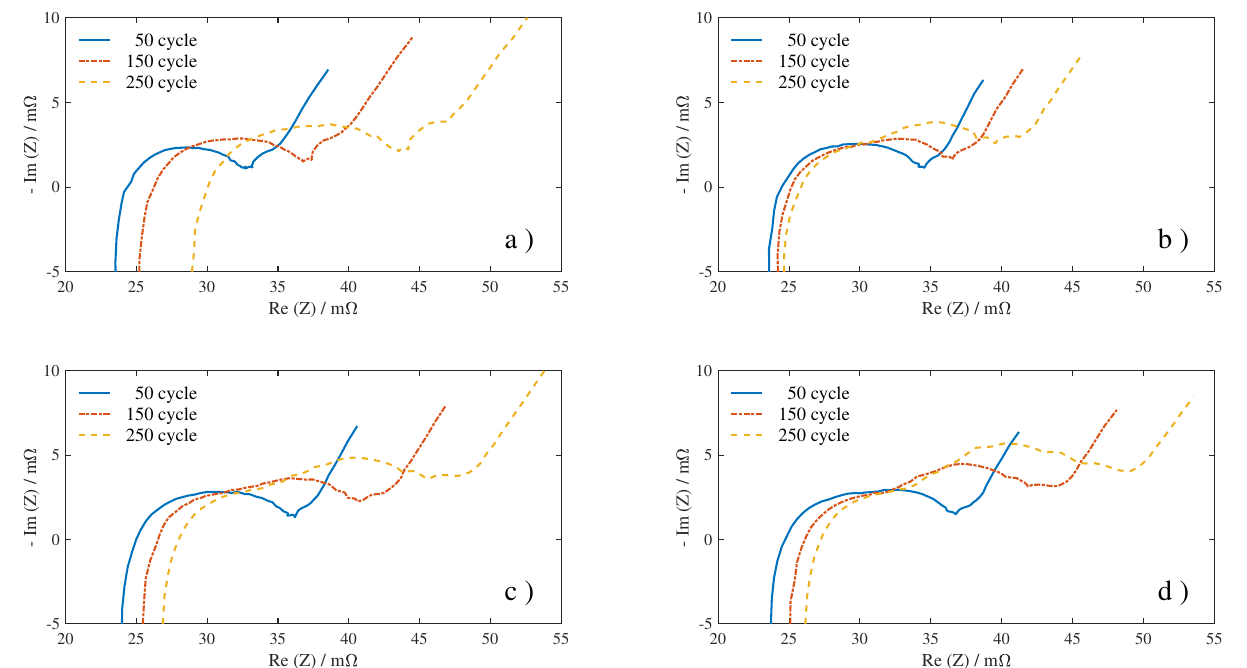
Figure 3. The impedance spectra obtained at 20% SoC with 500 mA excitation for the battery tested under: ( a ) 25 ◦ C@1–1 C condition; ( b ) 25 ◦ C@0.5–1 C condition; ( c ) 45 ◦ C@1–1 C condition; and ( d ) 45 ◦ C@0.5–1 C condition.